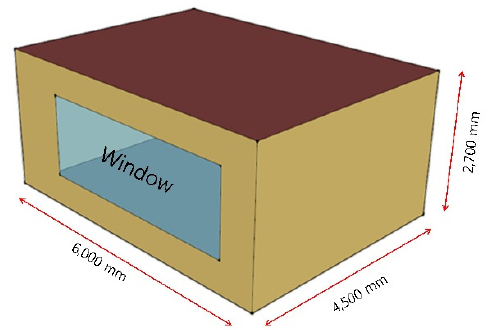
Figure 2. Schematic diagram of standard building modeling.